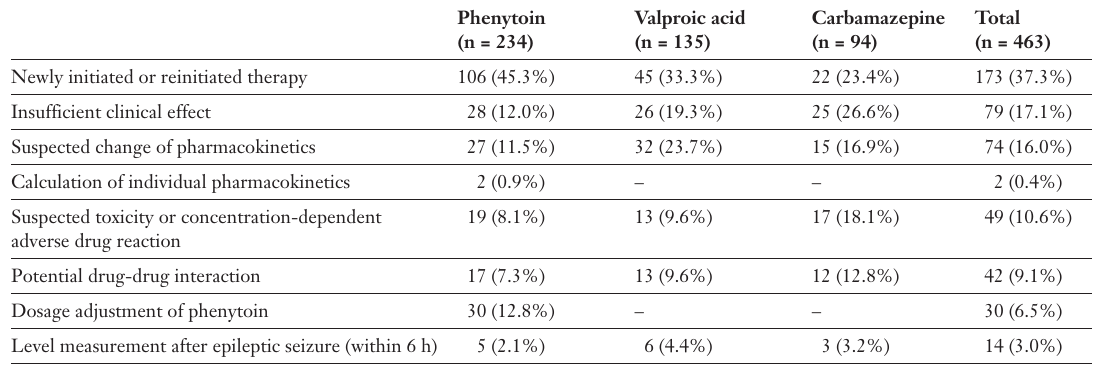
Overview on appro- priateness of 602 drug level measure- ments for phenytoin, carbamazepine or valproic acid with re- gard to indication and timing and the combination of both